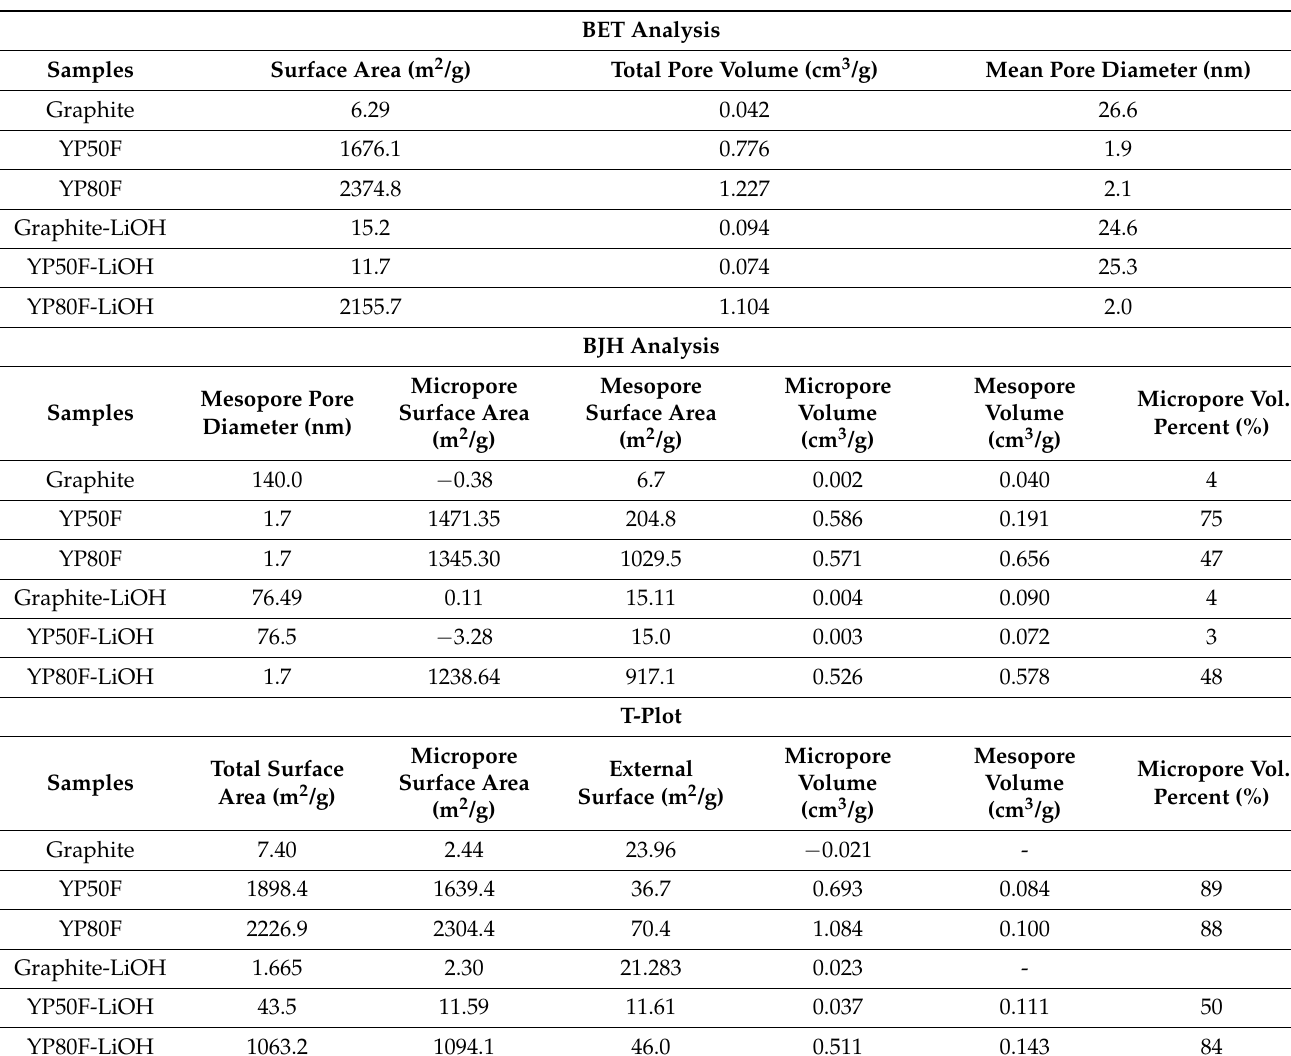
Table 2. Nitrogen adsorption–desorption isotherms of bare graphite, YP50F, YP80F and LiOH-treated samples.